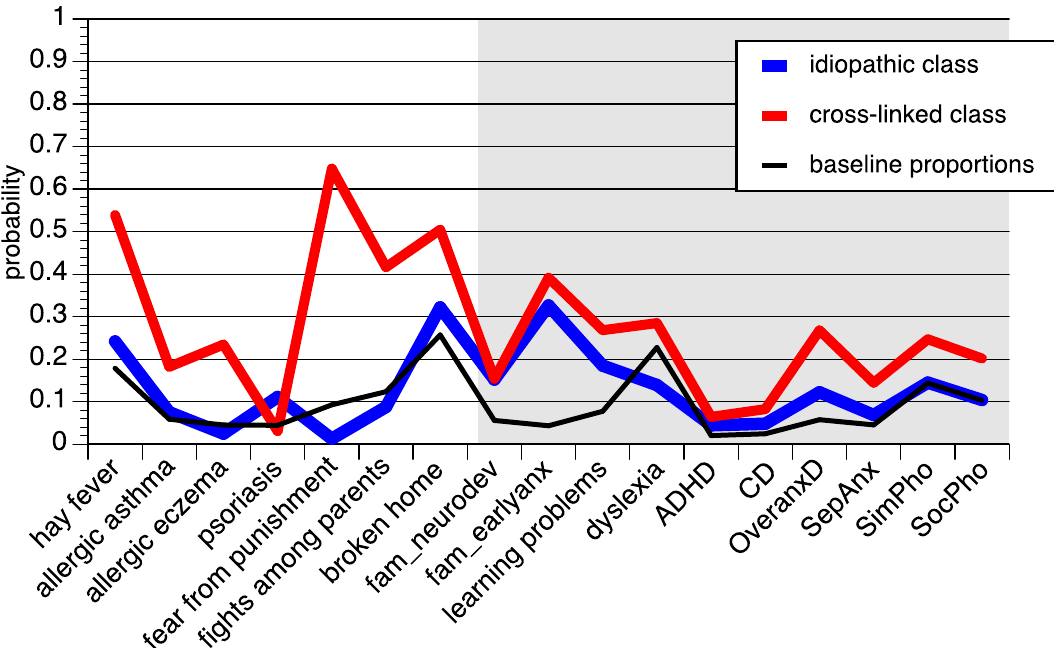
Fig 2. Probabilities of the two class LCA of stuttering and baseline proportions of risk / associated factors in the PsyCoLaus study. The grey area denotes items whose probabilities were assigned post hoc to the latent classes. The items were grouped and their probabilities were connected by lines in order to facilitate examination of the